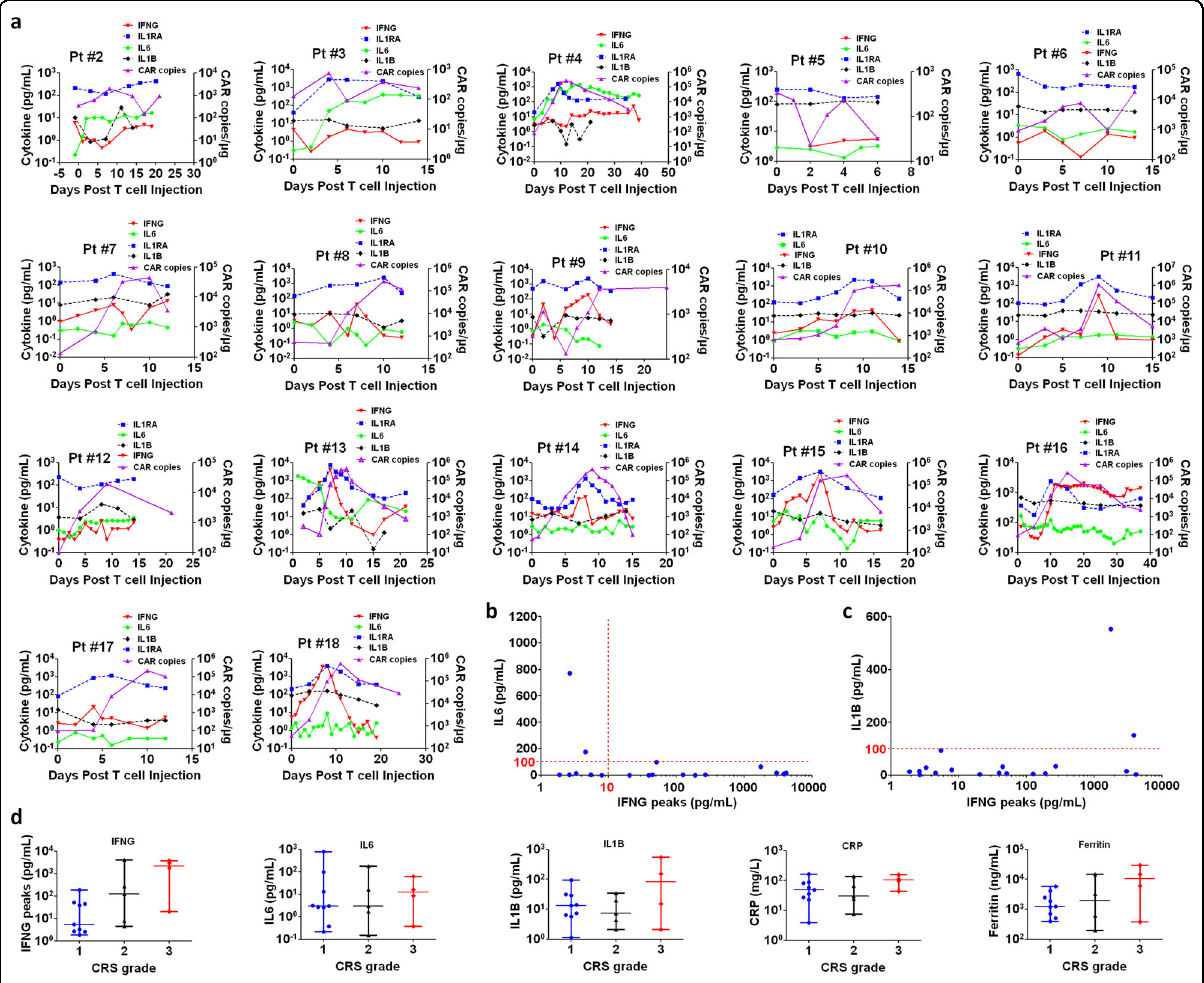
Fig. 2 CART expansion, cytokine changes, and CRS in the patients. Patients (as numbered in Table 1) with refractory or relapsed ALL, CLL, Lymphoma, or MM were enrolled and treated with anti-CD19 or anti-BCMA CART secreting anti-IL6 scFv and IL1RA. After CART infusion, patients were monitored for clinical signs of CRS and examined for clinical response of tumor remission. a Changes of IFNG, IL6, IL1RA, IL1B, and CAR vector copies in blood. b Plot of IFNG peak levels versus the IL6 concentration at the time of IFNG peak during CRS. c Plot of IFNG peak levels versus the IL1B concentration at the time of IFNG peak during CRS. d The relationship between CRS gradings and IFNG peaks, or IL6, IL1B, CRP, and Ferritin levels at the time of IFNG peaks during